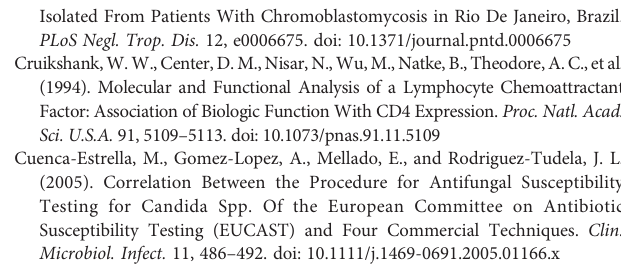
Supplementary Figure S1 | The comparison of each cytokines between severe vs mild group, and tested by T test. The p value (-log 10 P) and fold change (FC) (log 2 FC), were plot indicated the cytokines with statistical support between these two groups. Purple dot indicated the different makers between two groups